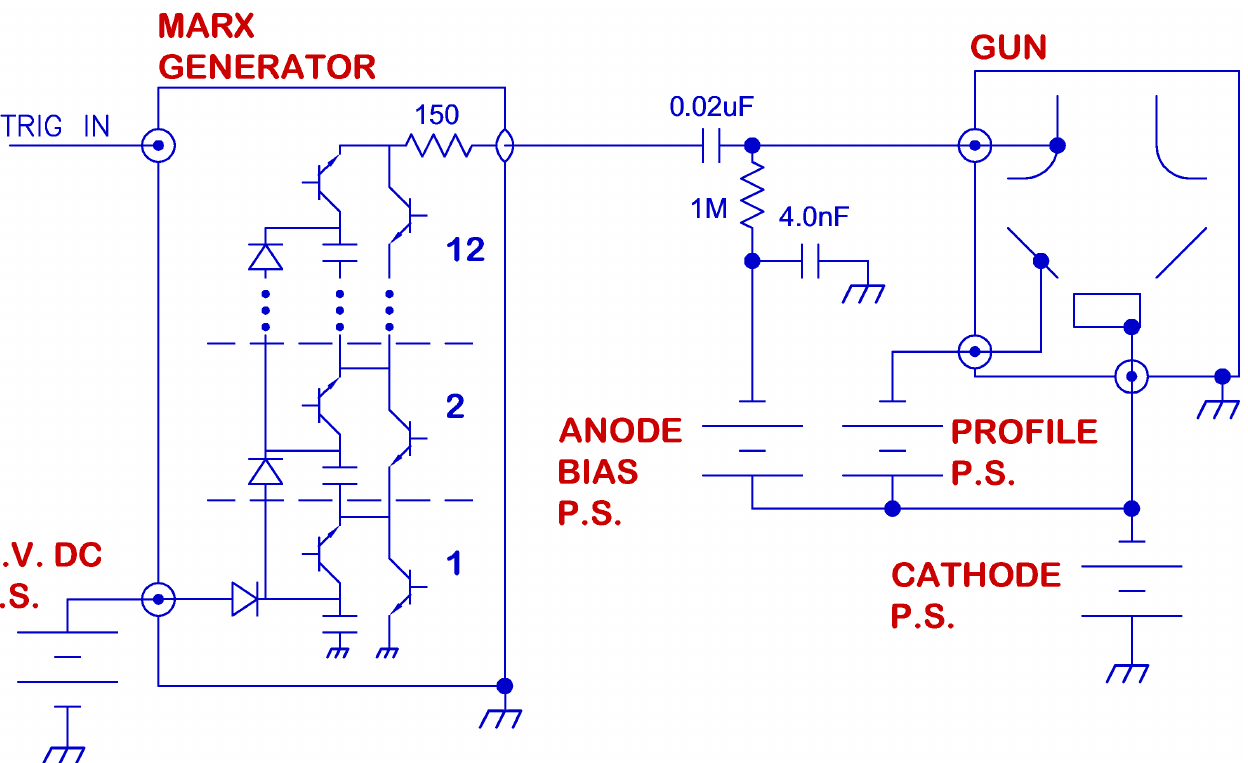
FIG. 18. (Color) Electron gun driving scheme. Only the cathode, the control electrode (profiler), and the anode of the electron gun are